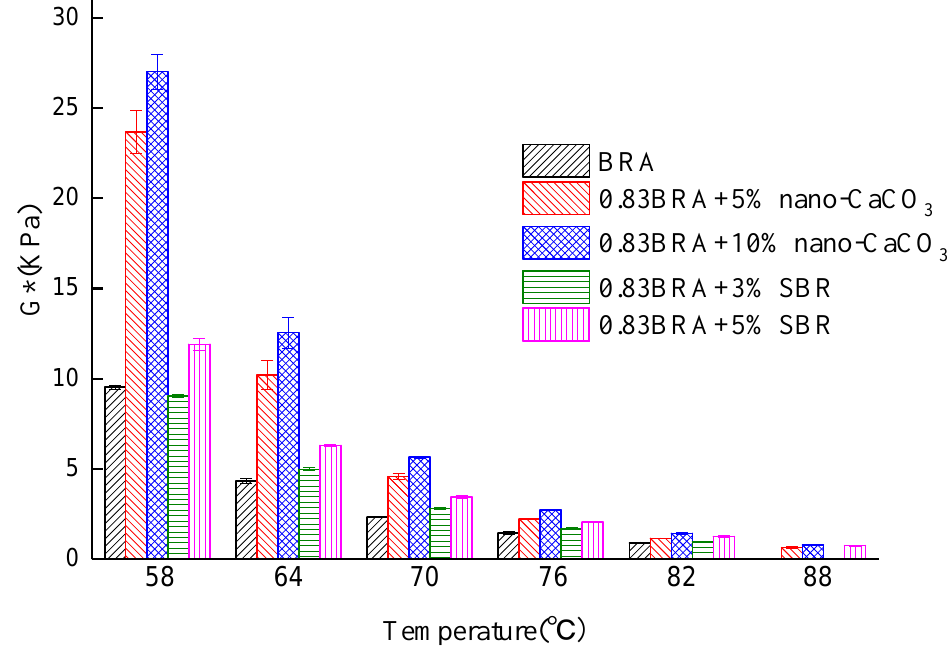
Figure 2. The relationship between complex shear modulus G* and the temperature of nano-CaCO 3 /BRA and SBR/BRA compound-modified asphalt.